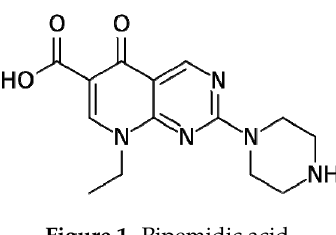
Figure 1. Pipemidic acid.